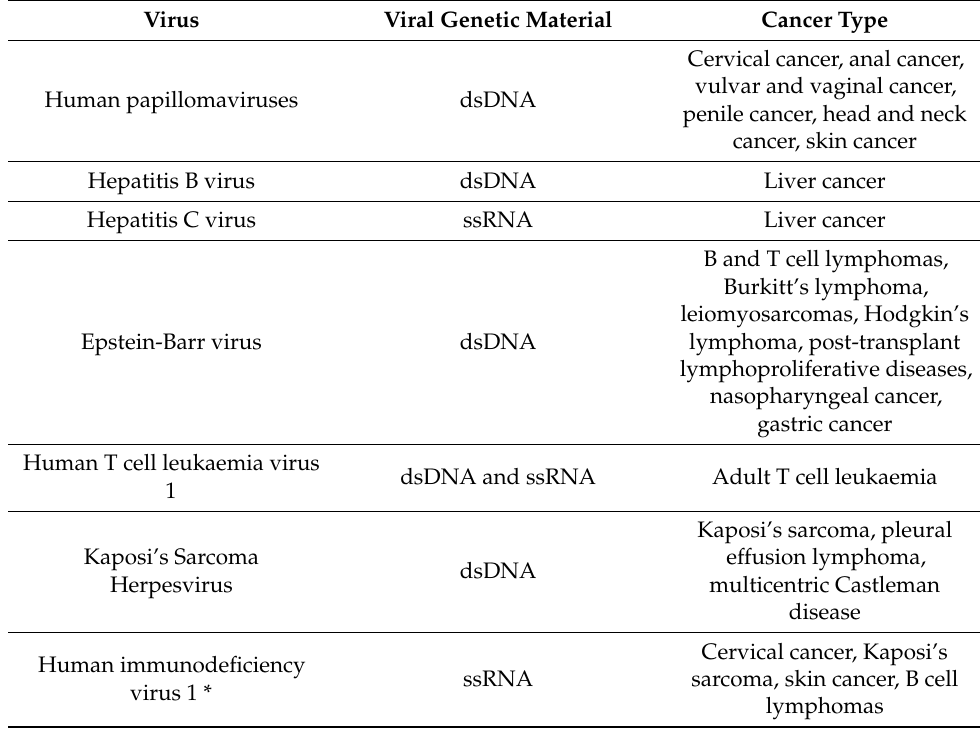
Table 1. Virally-Induced Cancers and the Associated Viral